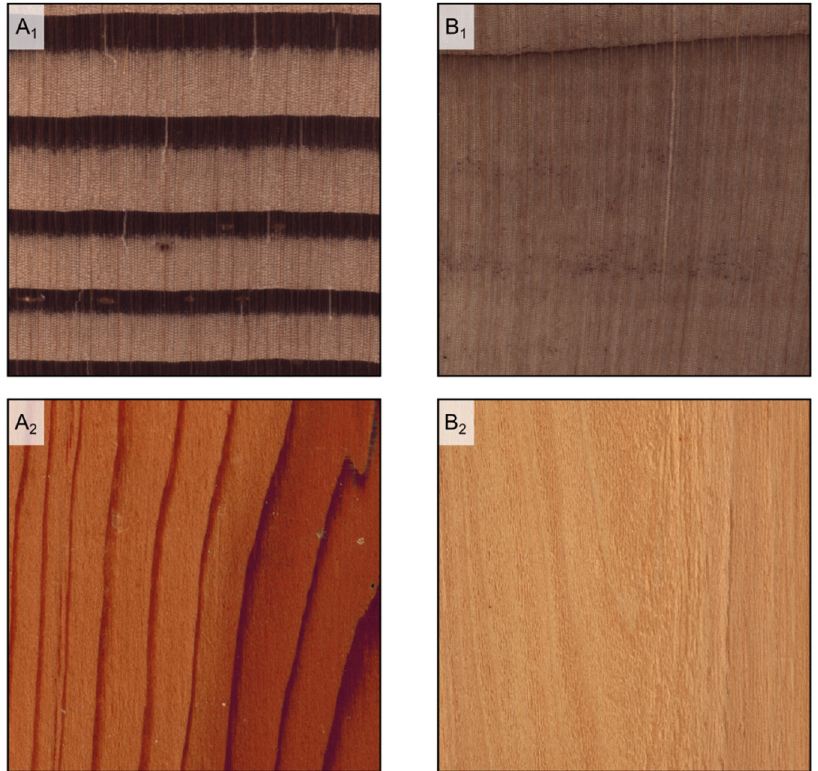
Figure 5. Earlywood/latewood transition. Pseudotsuga menziesii is an example of abrupt transition (( A 1 ), transverse section) and evident wood figure is (( A 2 ), tangential section); Cupressus sempervirens is an example of gradual transition (( B 1 ), transverse section) and faint wood figure (( B 2 ), tangential section).